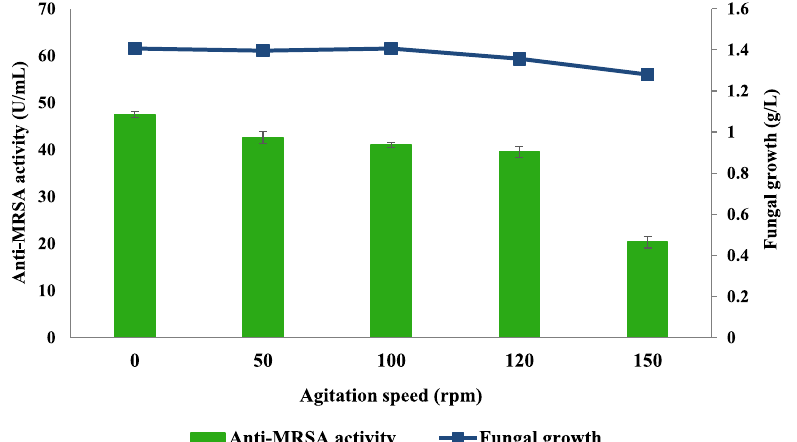
Fig. 7. Effects of agitation speeds on the production of anti-MRSA activity and fungal growth by L. pseudotheobromae IBRL OS-64. Different letters indicate significant differences between means (Duncan, p<0.05). Standard deviation values of triplicate analyses are shown by error